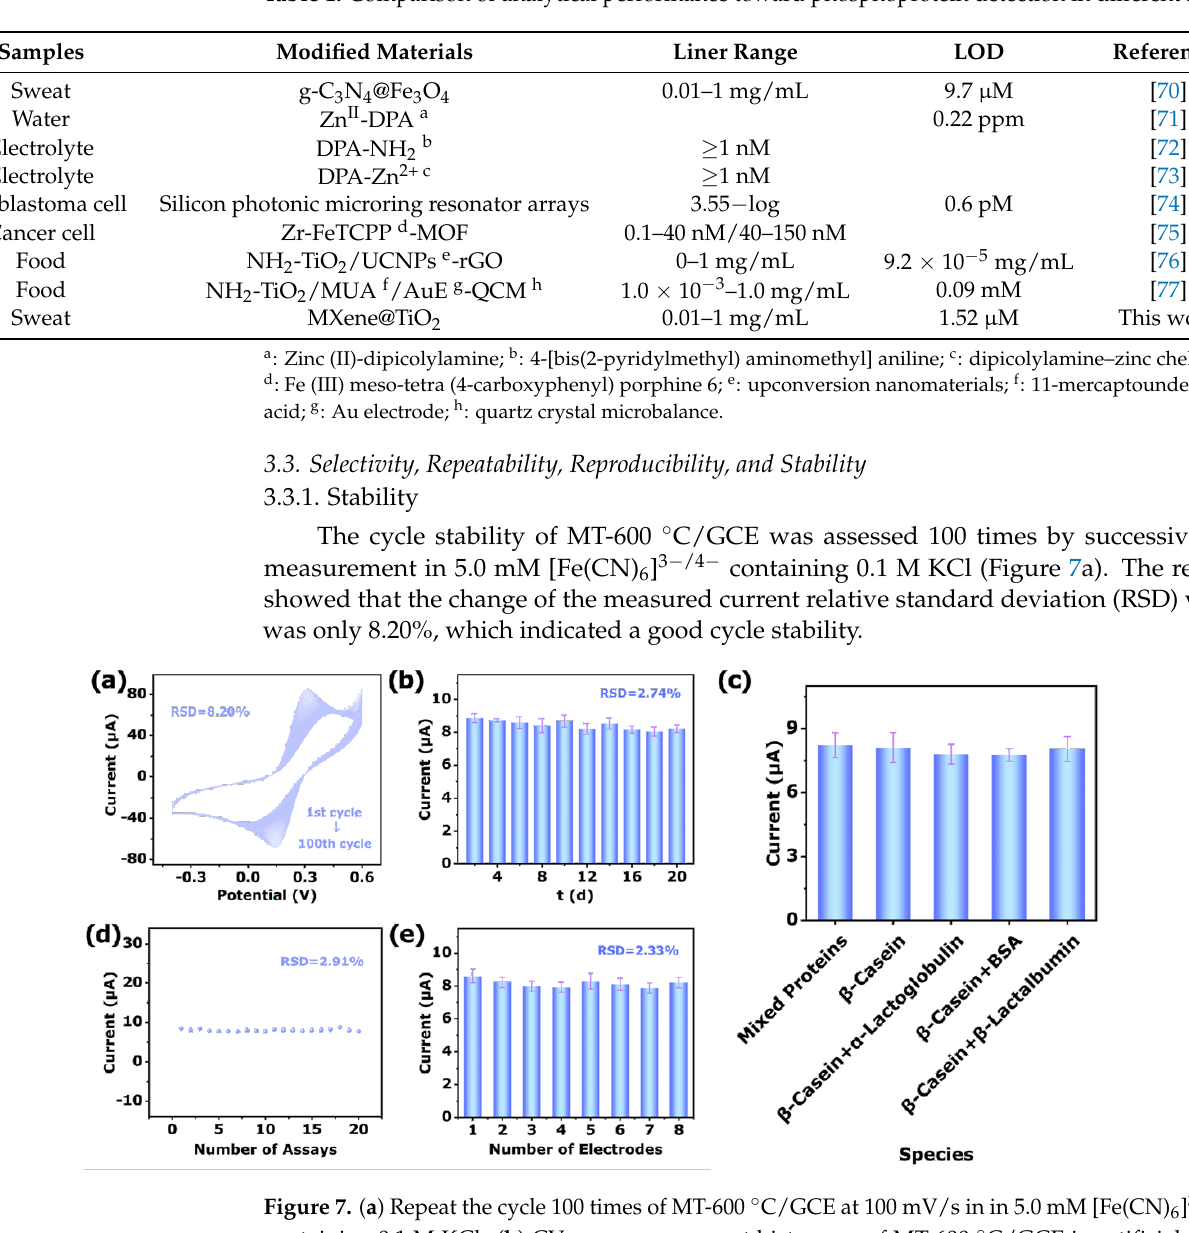
Table 1. Comparison of analytical performance toward phosphoprotein detection in different fields.